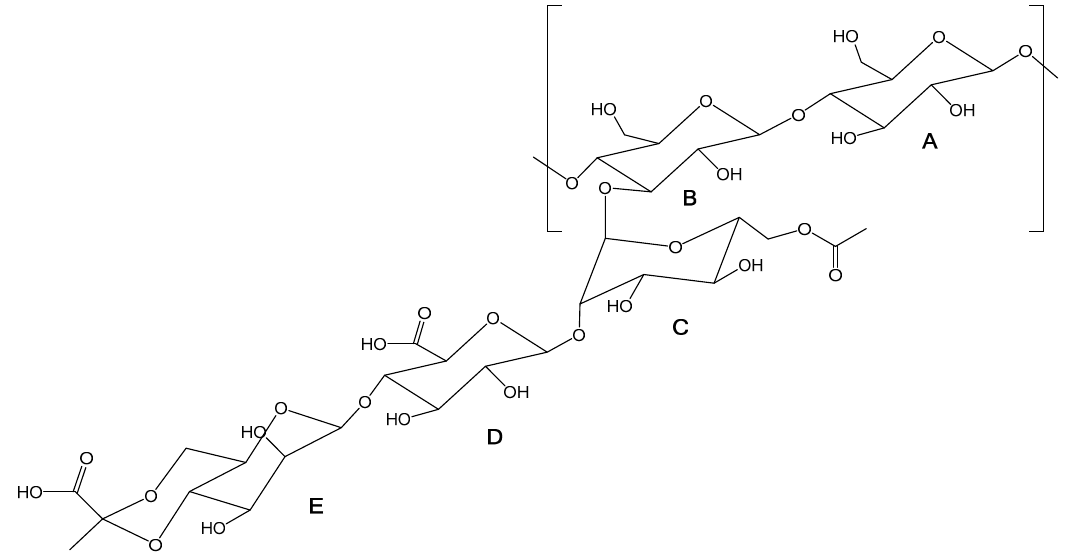
Figure 2. Chemical structure of native xanthan gum molecule: A , B : β - D -glucose ; C : O-acetylated α - D -mannose; D : β - D -glucuronic acid; E : pyruvated β - D -mannose unit (adapted from [36]).